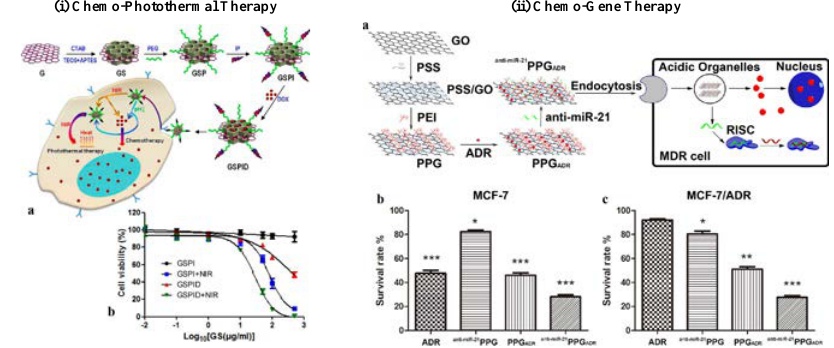
Fig. 5. Graphene-based nanomaterials for combined therapies. (i) Chemo-photothermal therapy. (a) Design of GSPID As a Multifunctional Drug Delivery System for Combined Chemo-Photothermal Targeted Therapy of Glioma (b) Cell viability pro¯les of glioma cells under di®erent treatments. Reproduced with permission from Ref. 100. Copyright 2013 American Chemical Society. (ii) Chemo- gene therapy. (a) Schematic of the PPG fabrication and MDR reversion. Relative survival rate of MCF-7 cells (b) and MCF-7/ADR cells (c) after being treated with ADR, anti-miR-21PPG, PPGADR and anti-miR-21PPGADR for 24h. Untreated MCF-7 and MCF-7/ADR cells were served as control in each experiment. Reproduced with permission from Ref. 114. Copyright 2013. (iii) Chemo-gene-pho- tothermal therapy. (a) Targeted gene-mediated thermochemotherapy for drug-resistant tumor. Apo- ptosis rate of MCF-7/ADR cells treated by (b) PBS ( (cid:1)Þ , (c) Dox ( (cid:1)Þ , (d) PPG-FA ( þÞ , (e) PPG-FA/ Dox ( þÞ , (f) PPG-FA/siRNA/Dox ( (cid:1)Þ and (g) PPG-FA/siRNA/Dox ( þÞ were tested by °ow cyto- metry. They are measured by the average °uorescent intensity (FL) treated with Annexin V-FITC/PI. ( þÞ ; 808nm irradiation (2W/cm 2 , 5min); ( (cid:1)Þ ; without irradiation. Reproduced with permission from Ref. 115. Copyright 2017. (iv) Photothermal-photodynamic therapy. Photothermally enhanced delivery of PDT by graphene. (a) – (c) Confocal images of KB cells incubated with GO-PEG-Ce6 (5 (cid:2) M of Ce6 equivalent) at 37 (cid:5) C with (b) or without (a) 808nm laser irradiation (360J/cm 2 ) and cells incubated at 43 (cid:5) C in the dark (c). (d) and (e) Cell uptake of GO-PEG-Ce6 under the three conditions at Ce6 concentrations of 2.5 (cid:2) M (d) and 5 (cid:2) M (e) determined by the measured °uorescence intensities of cell lysate samples. (f) and (g) Cell viability data of KB cells incubated with GO-PEG-Ce6, free Ce6, or GO-PEG, respectively, at Ce6 concentrations of 2.5 (cid:2) M (f) and 5 (cid:2) M (g). Black, red, blue, and green bars represent samples without any light exposure, with both 808nm (360 J/cm 2 ) and 660nm (15J/cm 2 ) light irradiation, with only 660nm light exposure, and with only 808nm light exposure, respectively. Relative cell viabilities in all samples were normalized to the control saline-added samples without laser irradiation (100% viability). Reproduced with permission from Ref. 116. Copyright 2011 American Chemical